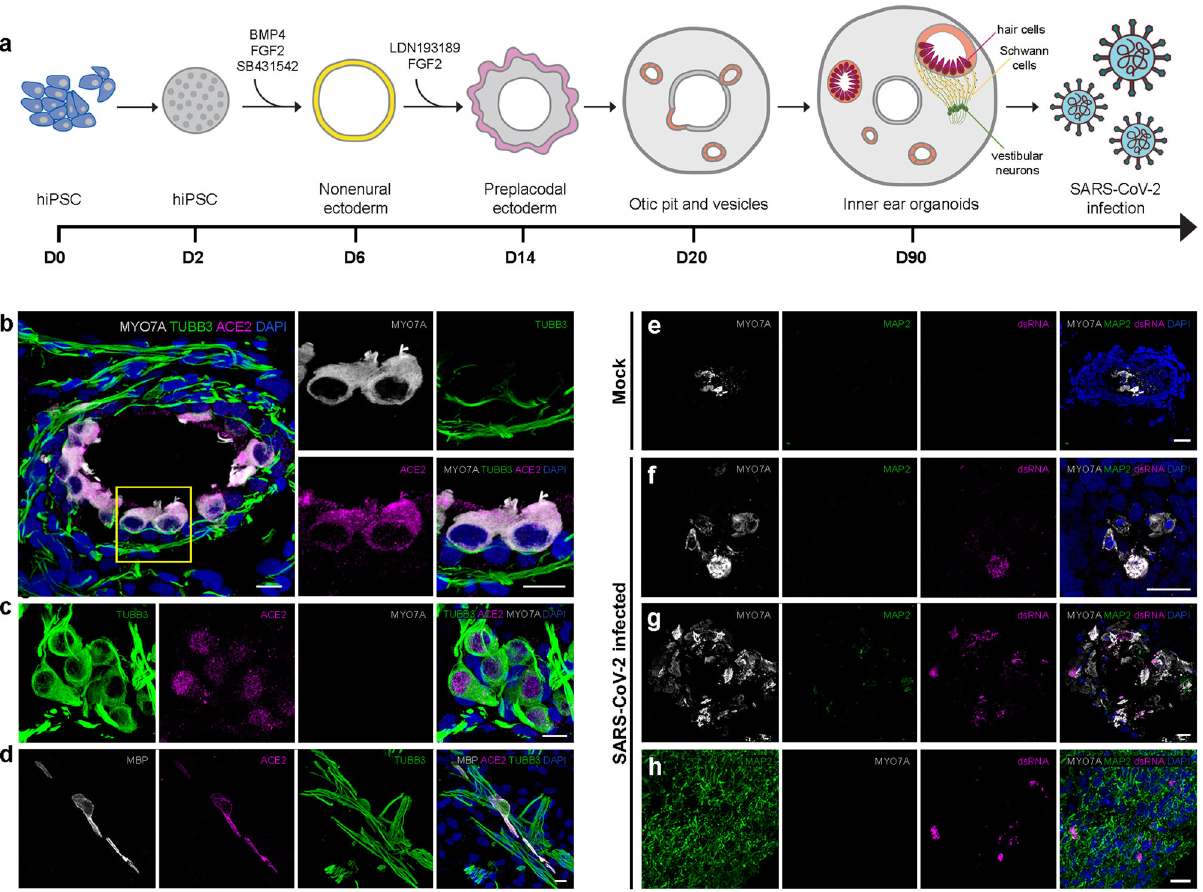
Fig. 5 Hair cell-like cells and neurons from inner ear organoids infected with SARS-CoV-2. a Schematic overview of the generation of inner ear organoid from hiPSCs and infection with SARS-CoV-2. b – d Protein expression of ACE2 in inner ear vestibular organoids containing MYO7A + hair cells ( b ), TUBB3 + cell body of ganglion neurons ( c ), and MBP + Schwann cells ( d ) generated from hiPSC line SK8-A. Scale bars = 10 μ m. e – h Immuno fl uorescent staining of mock ( e ) and SARS-CoV-2-infected differentiated organoid culture. Viral dsRNA, stained by the J2 antibody, colocalized with the hair cell marker MYO7A (shown in ( f ) and ( g )) and neuronal marker MAP2 (shown in ( h )). Scale bars = 20 μ m. Representative images from at least 3 independent